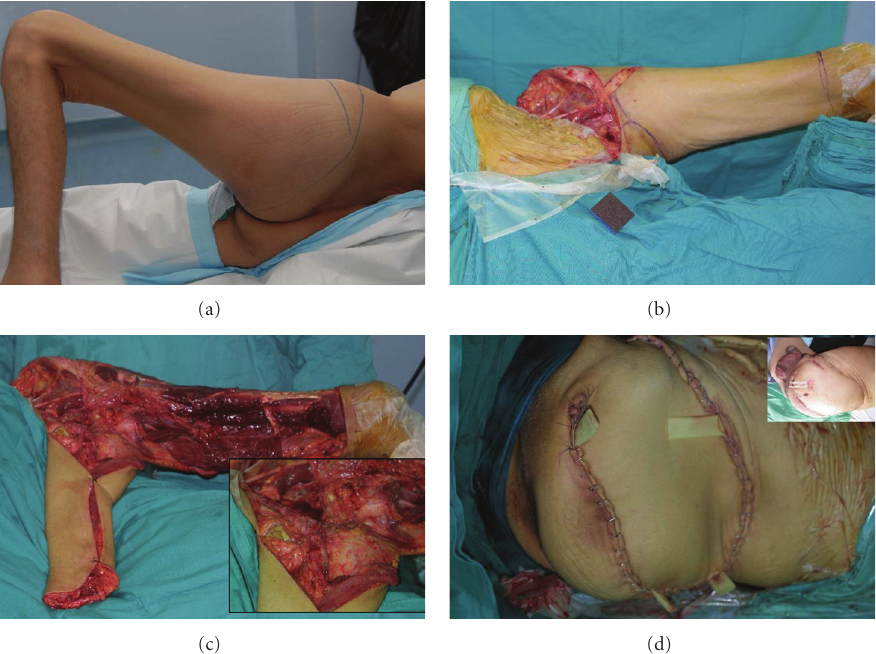
Figure 1: 49-year-old man with late presentation of osteosarcoma involving ilium and ischium. He had hemipelvectomy and reconstruction with anteromedial thigh fillet flap. (a) Preoperative photo showing large swelling over the left hip and gluteal area. (b) Intraoperative picture showing the proposed area for fillet thigh flap to be harvested. (c) Flap was completely raised including adductor muscle group, gracilis, and sartorius. Left attached by the skin (proximal anteromedial area of groin) and its main vascular pedicle. (d) Early after procedure (Inset—Day 10 post